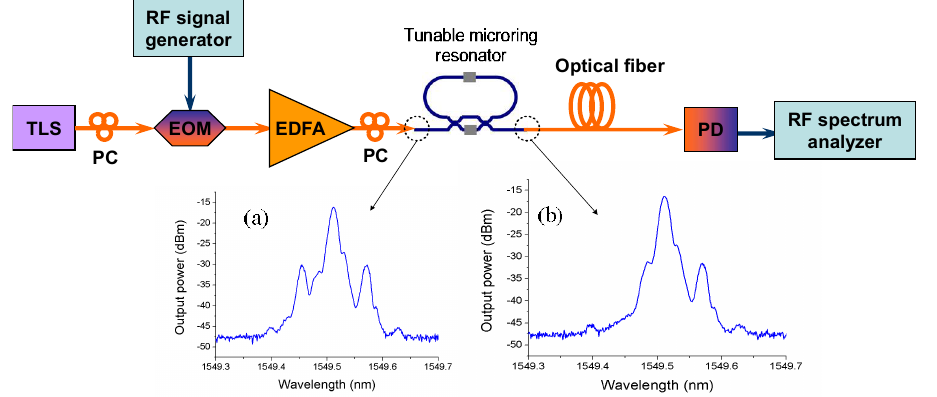
Figure 16. ( a ) The optical microscopic image of the fabricated polymer waveguide filter; ( b ) filter response spectra of the microring resonator by tuning the MZI based coupler; and ( c ) resonant wavelength tuning response [62]. Polymers 2018 , 10 , x FOR PEER REVIEW